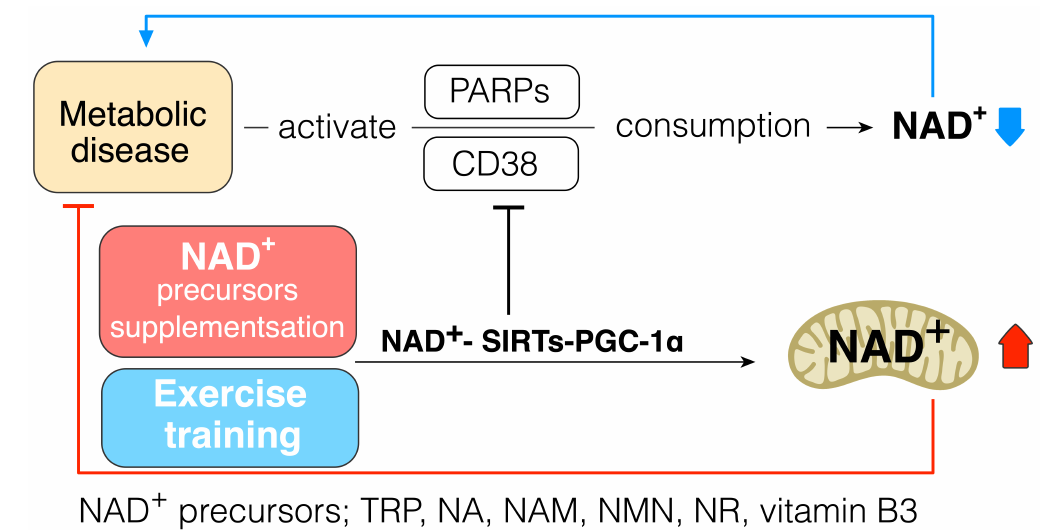
Figure 4. NAD + –SIRTs–PGC-1 α pathway increases NAD + pool and inhibits NAD + consumption. NAD + precursors: tryptophan (Trp), nicotinic acid (NA), nicotinamide (NAM), NAM mononucleotide (NMN), nicotinamide riboside (NR), vitamin B3; metabolic diseases: insulin resistance, type 2